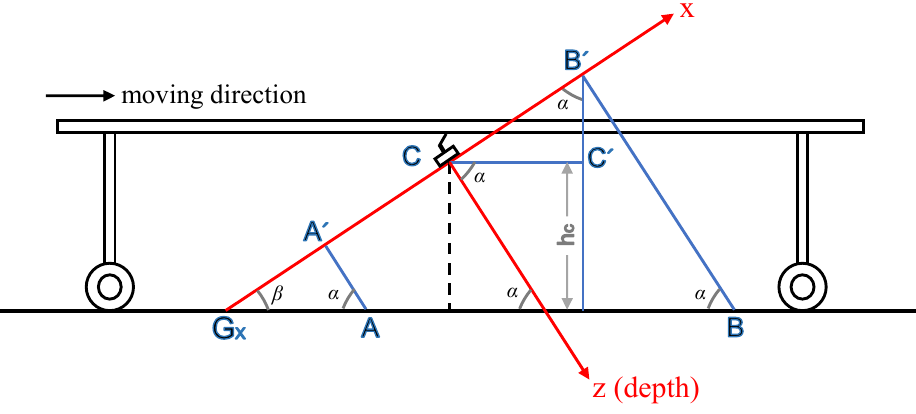
Figure 4. Sagittal illustration of the harvester and camera coordinate system.